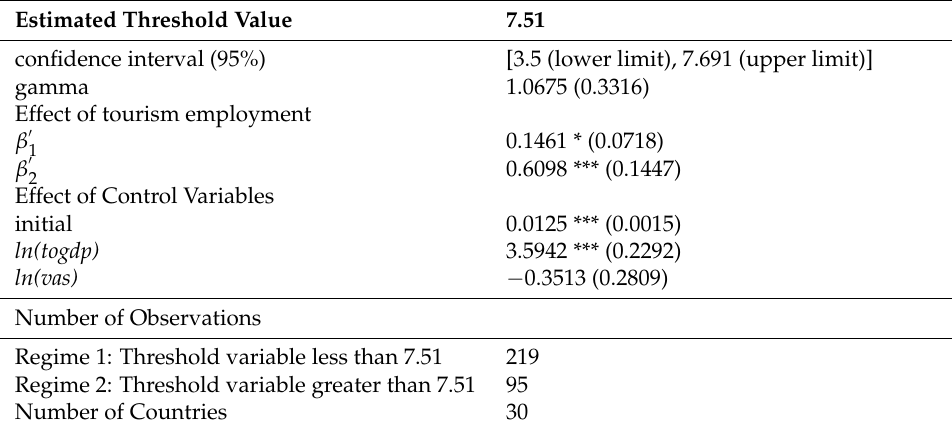
Table 3. Dynamic panel threshold estimates for Model 1.